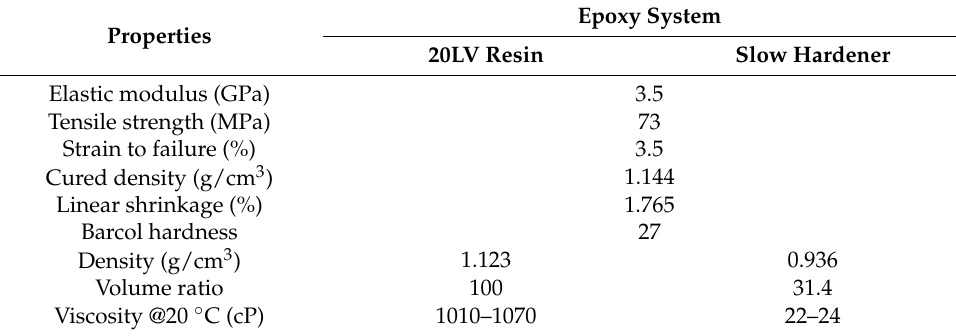
Figure 1. ( a ) Coconut fibre; ( b ) Flax fabric. Table 1. Mechanical properties of epoxy system. Table 1. Mechanical properties of epoxy